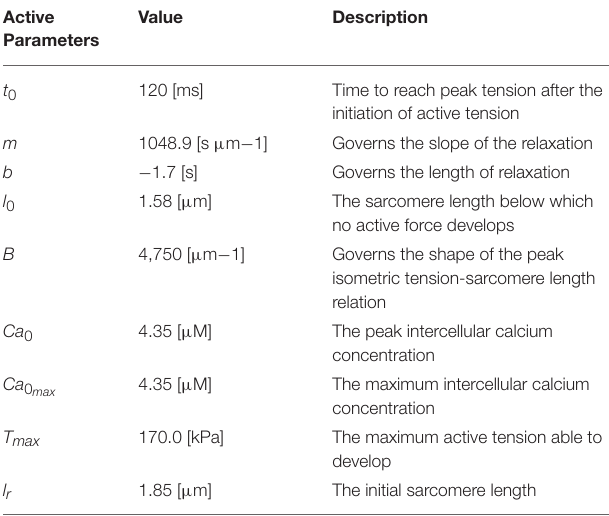
TABLE A1 | Parameter values and definitions for the time-varying elastance constitutive model. Active Parameters